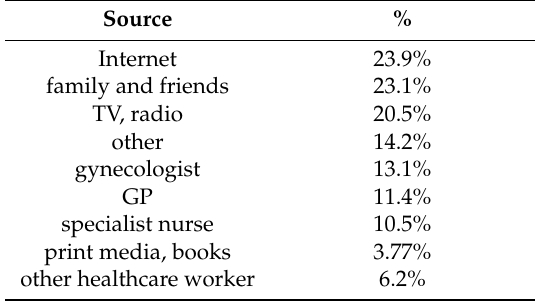
Table 5. The students’ sources of information about HPV infection and cervical cancer.